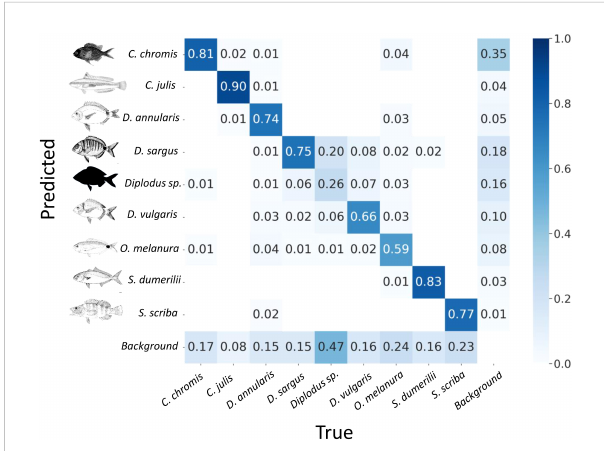
FIGURE 3 Confusion matrix based on YOLO results for eight species, background, and one genus ( Diplodus sp) that could not be attributed to other congeneric species. Refer to the text for further